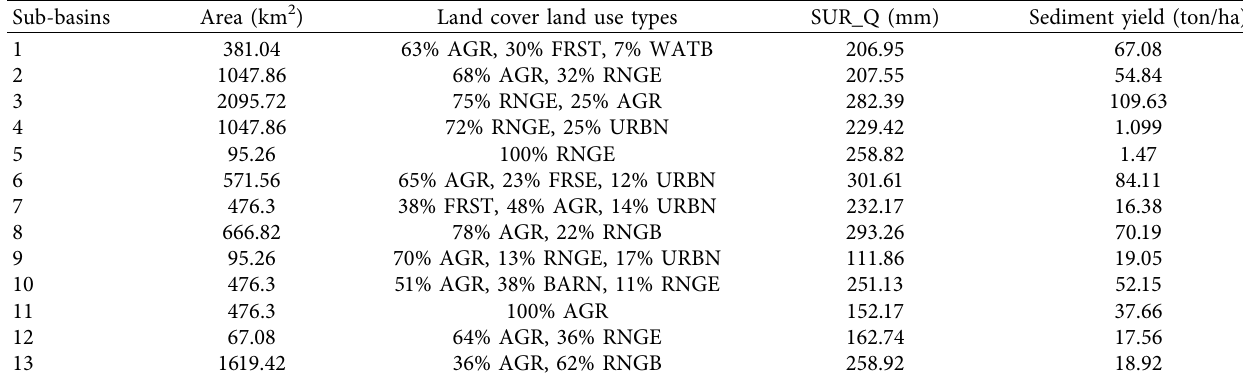
Table 8: Sub-basins’ dominant land cover, surface runoff, and sediment loading